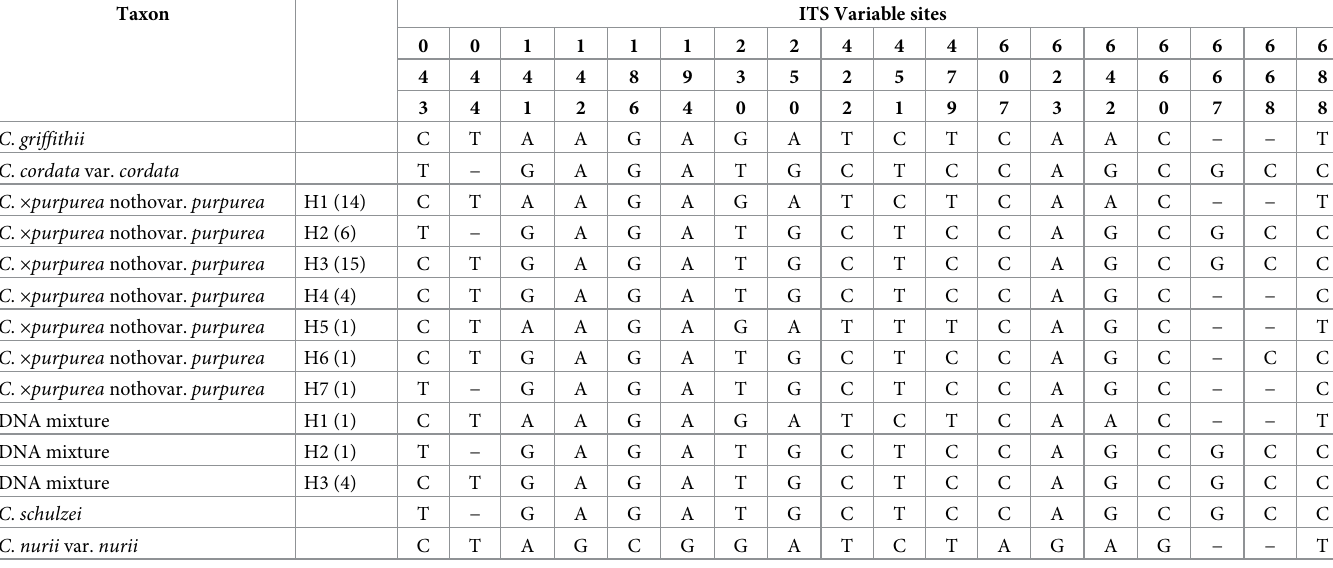
Table 2. Variable nucleotide sites of ITS sequences’ comparison of the clones and the putative parental species.